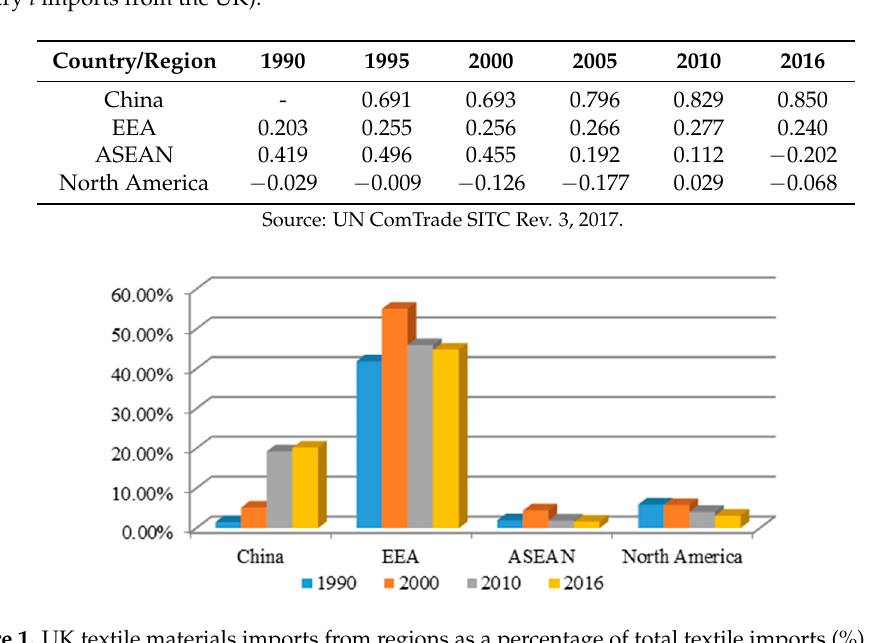
Table 3. RCA in textile materials of China, EEA, ASEAN and North America in UK market (revealed comparative advantage index RCA i = (X i /X)/(X wi /X w ), X i , X wi means textile export of country i to the UK and world, X, X w means total export of country i to the UK and the world. While RCA is calculated in this paper, added value is used instead of total export in order to avoid biases).